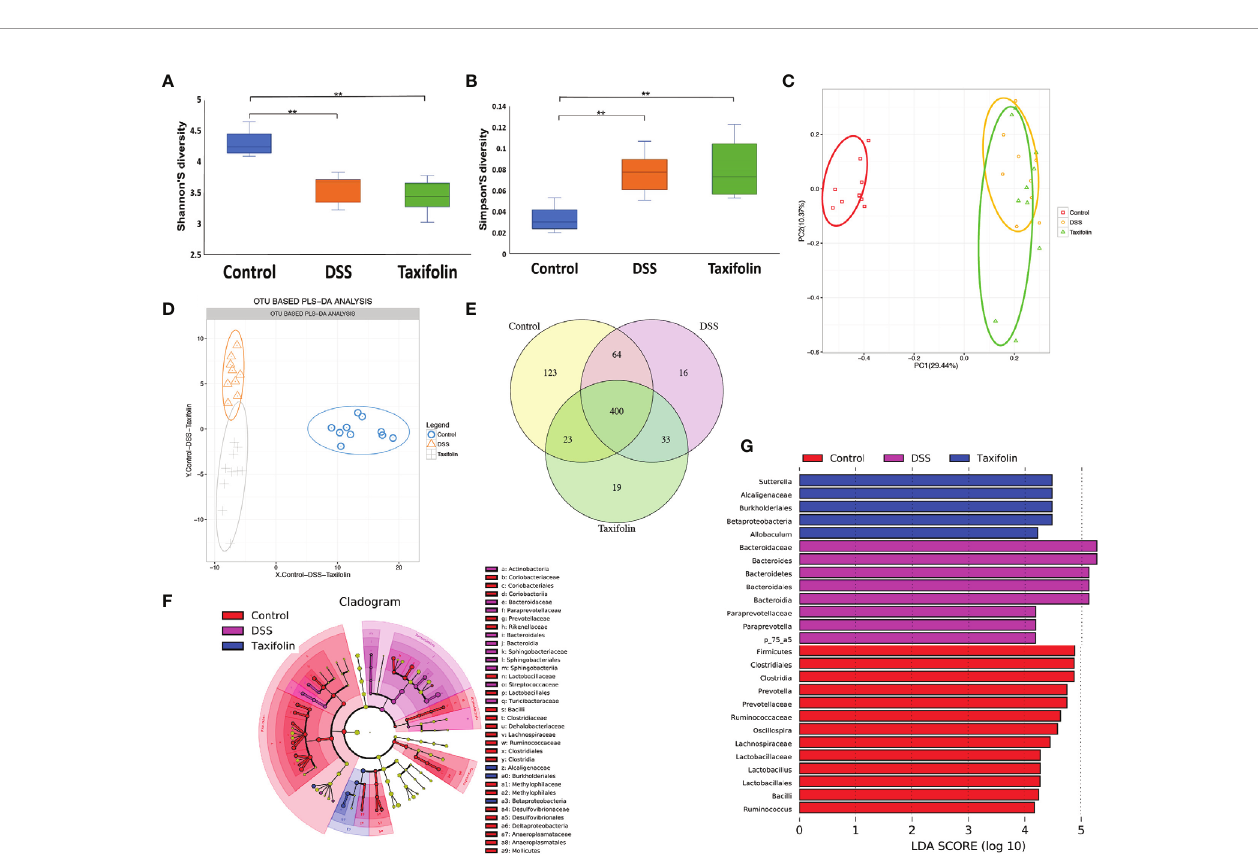
FIGURE 5 | Taxifolin altered the composition of the colon microbiota in colitis mice. (A , B) Alpha diversity was estimated by the Shannon and Simpson indexes; (C , D) Principal component analysis (PCA) plot and partial least squares discriminant analysis (PLS-DA) of gut microbiota; (E) Venn diagram of OTUs; (F) Taxonomic cladogram of LEfSe analysis. Different colors indicate the enrichment of the biomarker taxa in the control (red), DSS (pink), and taxifolin (purple) group. The circle from inside to outside means the rank from kingdom to species, and the circle size represents the taxa abundance in the community. (G) Linear discriminant analysis (LDA) score for different taxa abundances. Data were expressed as means ± SEM ( n = 10).** P <